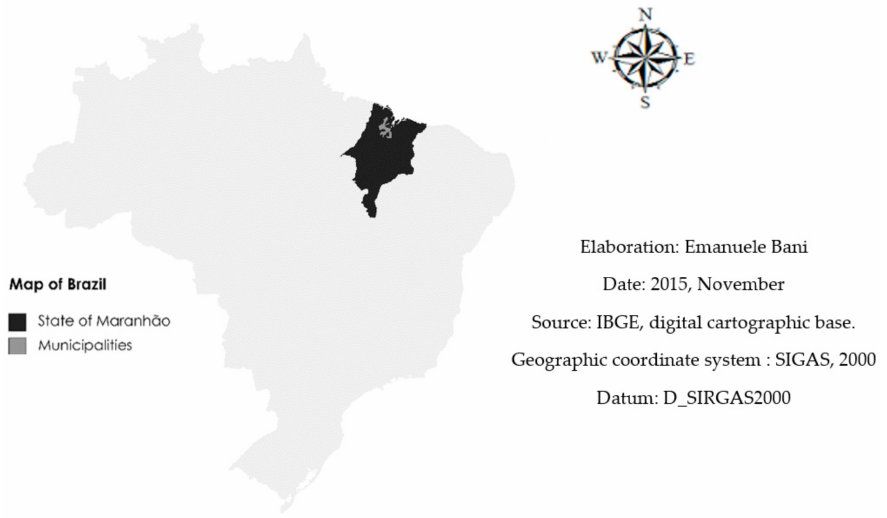
Figure 1. Region of Maranh ã o, Brazil, where the data were